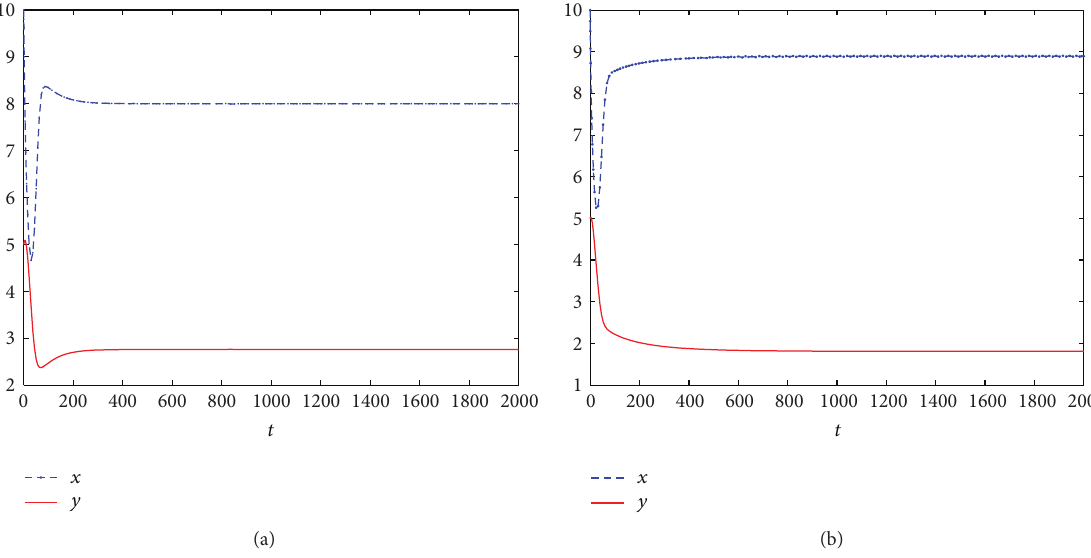
Figure 6: The infected steady state 𝐸 ∗ of system (2) is stable when 𝜏 = 0.55 (a) and 𝜏 = 0.75 (b). The rest parameter values are given in (ii), and the initial values are 𝑥 0 = 8 and 𝑦 0 = 5